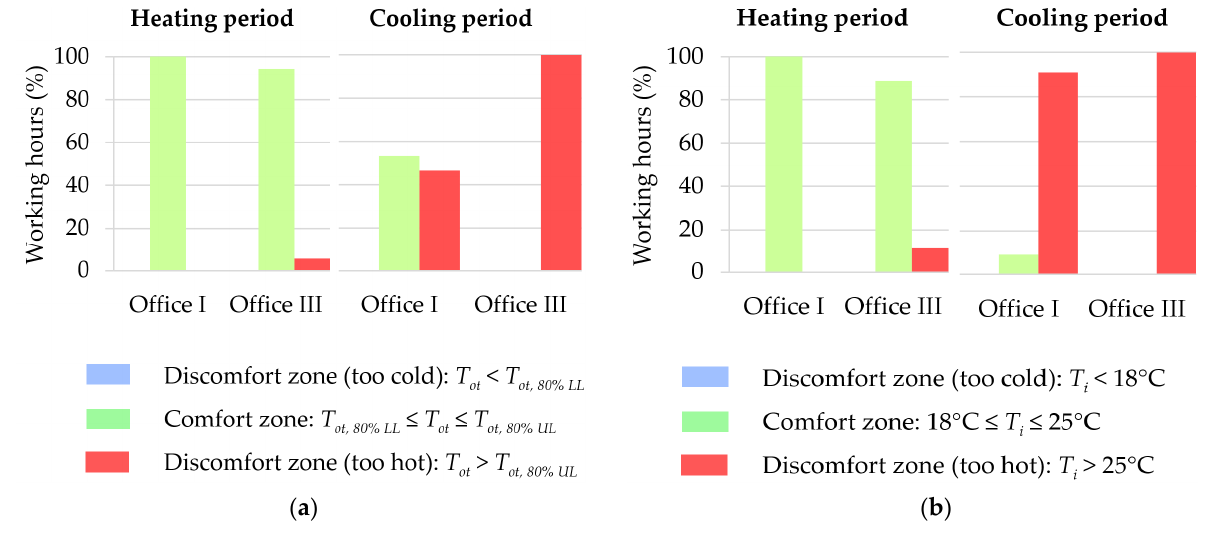
Figure 13. Percentage of working hours within thermal comfort inside office rooms I and III during the days with the VRV unit turned off (weekends): ( a ) ASHRAE 55 adaptive model, with 80% acceptability; ( b ) Portuguese legislation.